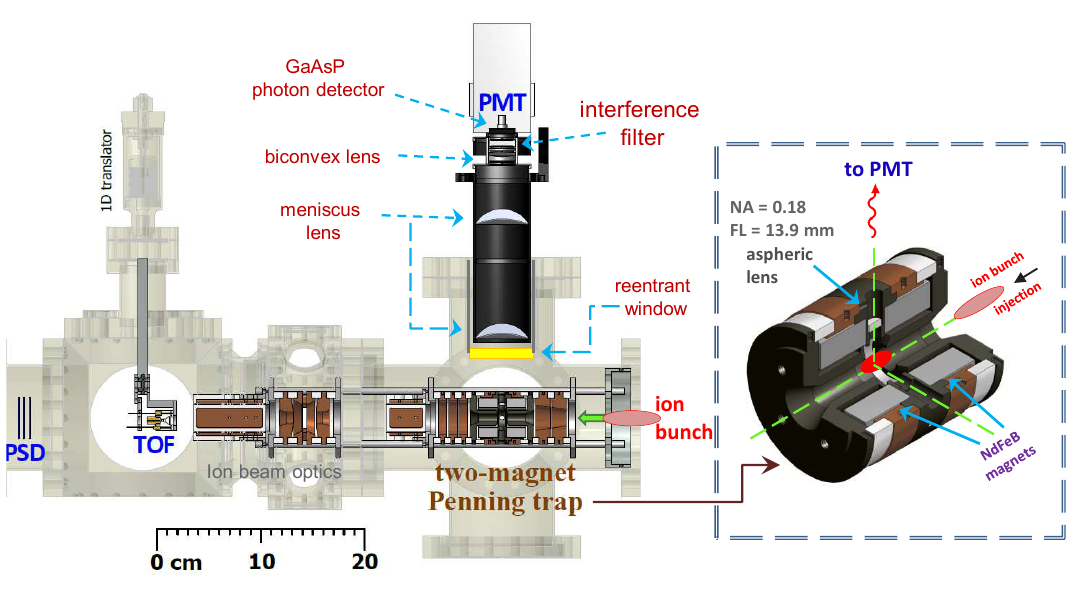
Figure 7. Schematic diagram for the detection of fluorescence from Kr 17+ ions isolated in a unitary Penning trap (centered on the six-way cross). Ion bunches are periodically injected into the trap from the right. An aspheric lens collects photons emitted by the captured ions (see the inset in the three-dimensional perspective). Above the reentrant window, an optical setup with a narrow bandpass filter relays light to a photon detector. At the end of each data acquisition cycle, stored ions are counted and analyzed by ejection to a TOF detector. NA, numerical aperture; FL, focal length